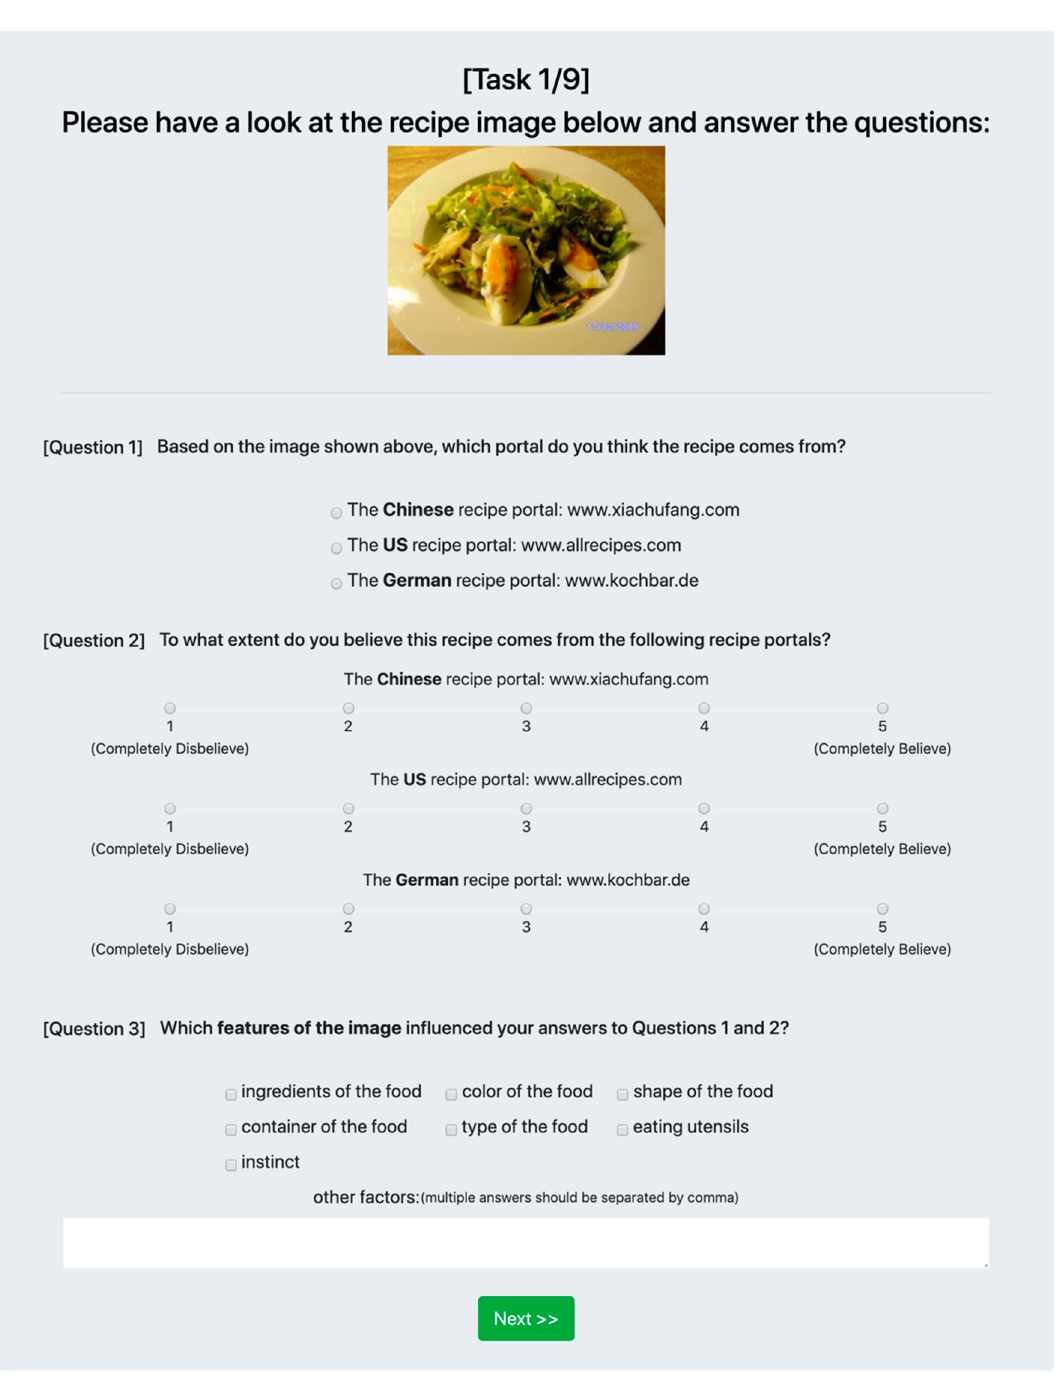
Figure 1. Example of the online survey.